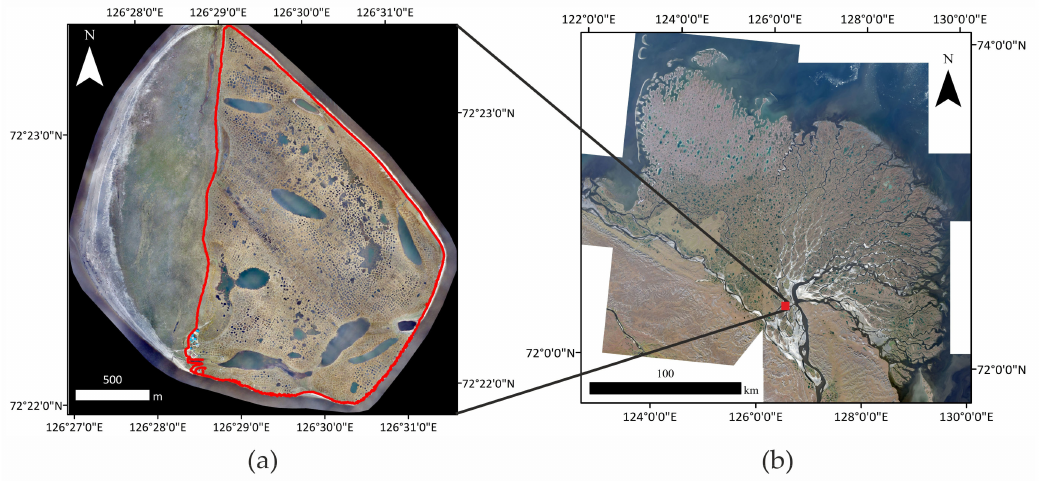
Figure 1. Location of the study area. ( a ) An obtained orthophoto map mosaic of Samoylov Island. The red line is the border of the analyzed first terrace surface. ( b ) Samoylov Island (red square) in a mosaic of satellite Sentinel-2 images of the Lena